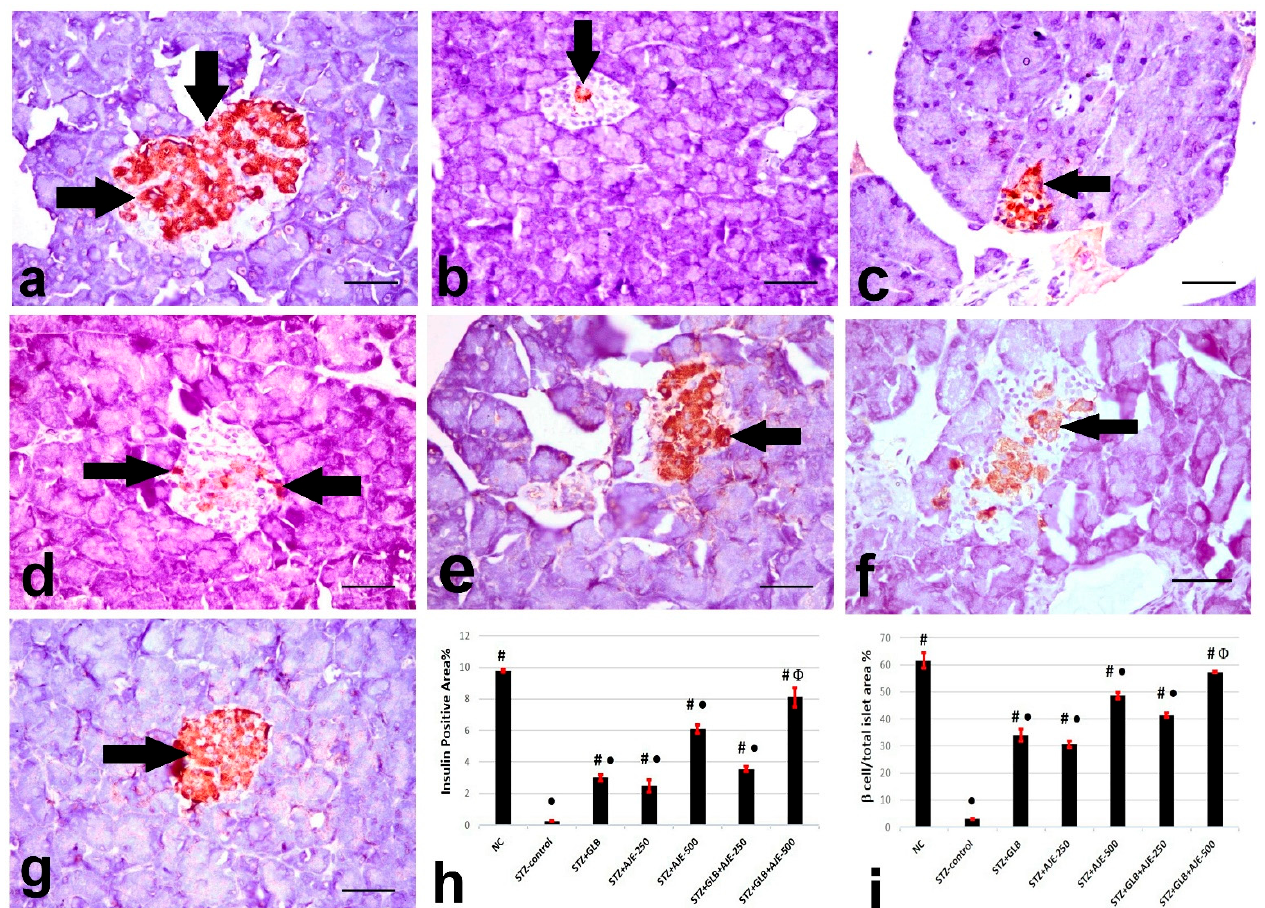
Figure 2. Representative insulin immunohistochemistry in β -cells (arrows) of the pancreatic islets of the different experimental groups: ( a ) NC group, ( b ) STZ-control group, ( c ) STZ + GLB-treated group, ( d ) STZ + AJE-250, ( e ) STZ + AJE-500 group, ( f ) STZ + GLB + AJE-250, and ( g ) STZ + GLB + AJE-500 group. Scale bar, 25 µm. ( h ) Bar chart represents the insulin content of β -cells %. ( i ) β -cell/total islet area %. Data are presented as the mean ± SEM ( n = 7). ● Statistically significant difference from the NC group at p ≤ 0.05. # Statistically significant difference from the STZ-control group at p ≤ 0.05. Փ S tatistically significant difference from the GLB group at p ≤ 0.05.